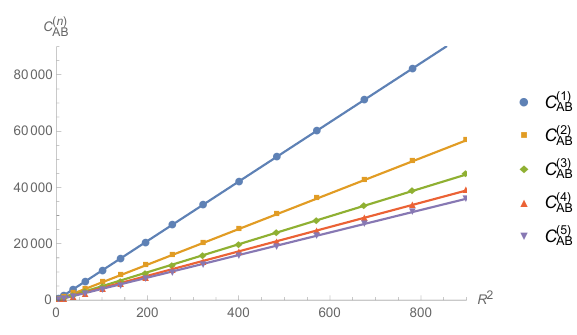
Figure 3 . The coe(cid:14)cient C ( n ) as a function of R 2 , where C ( n ) is the coe(cid:14)cient of the (R(cid:19)enyi) AB AB mutual information I ( n ) ( A; B ) of two disks A and B whose radii are R A = R B (cid:17) R . The lines are the best linear (cid:12)t.